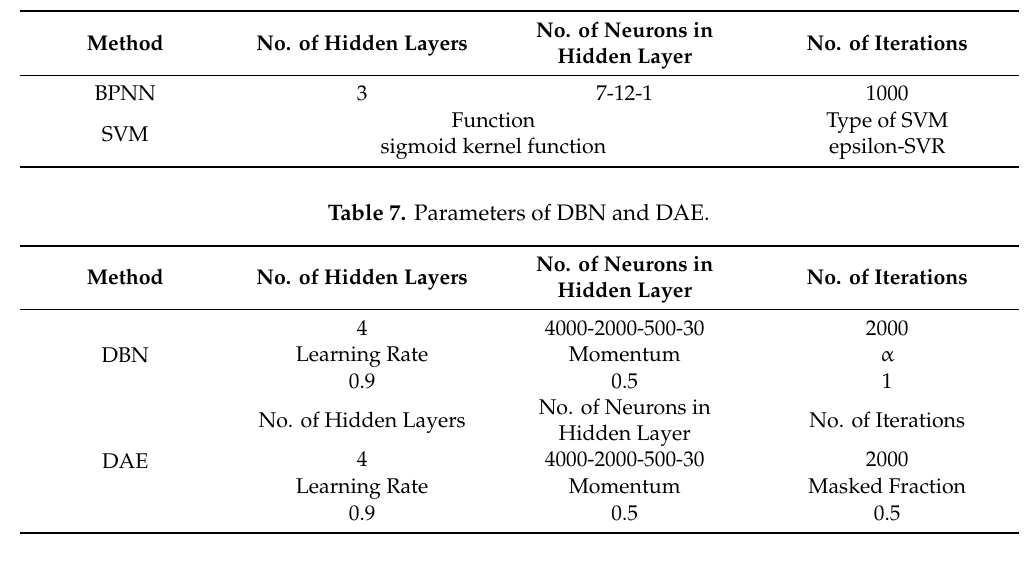
Table 6. Parameters of SVM and BPNN.